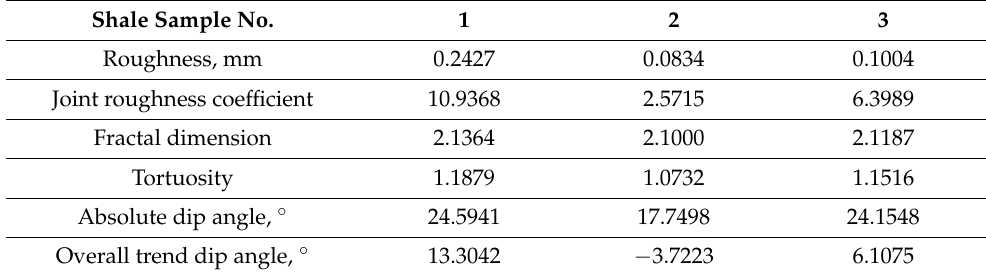
Table 7. Characteristics of shale fracture surface morphology. Shale Sample